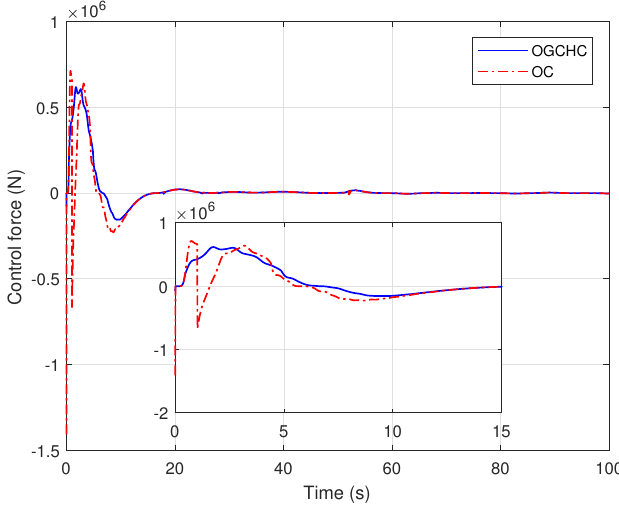
Figure 6. Control force with OC and OGCHC under case I.